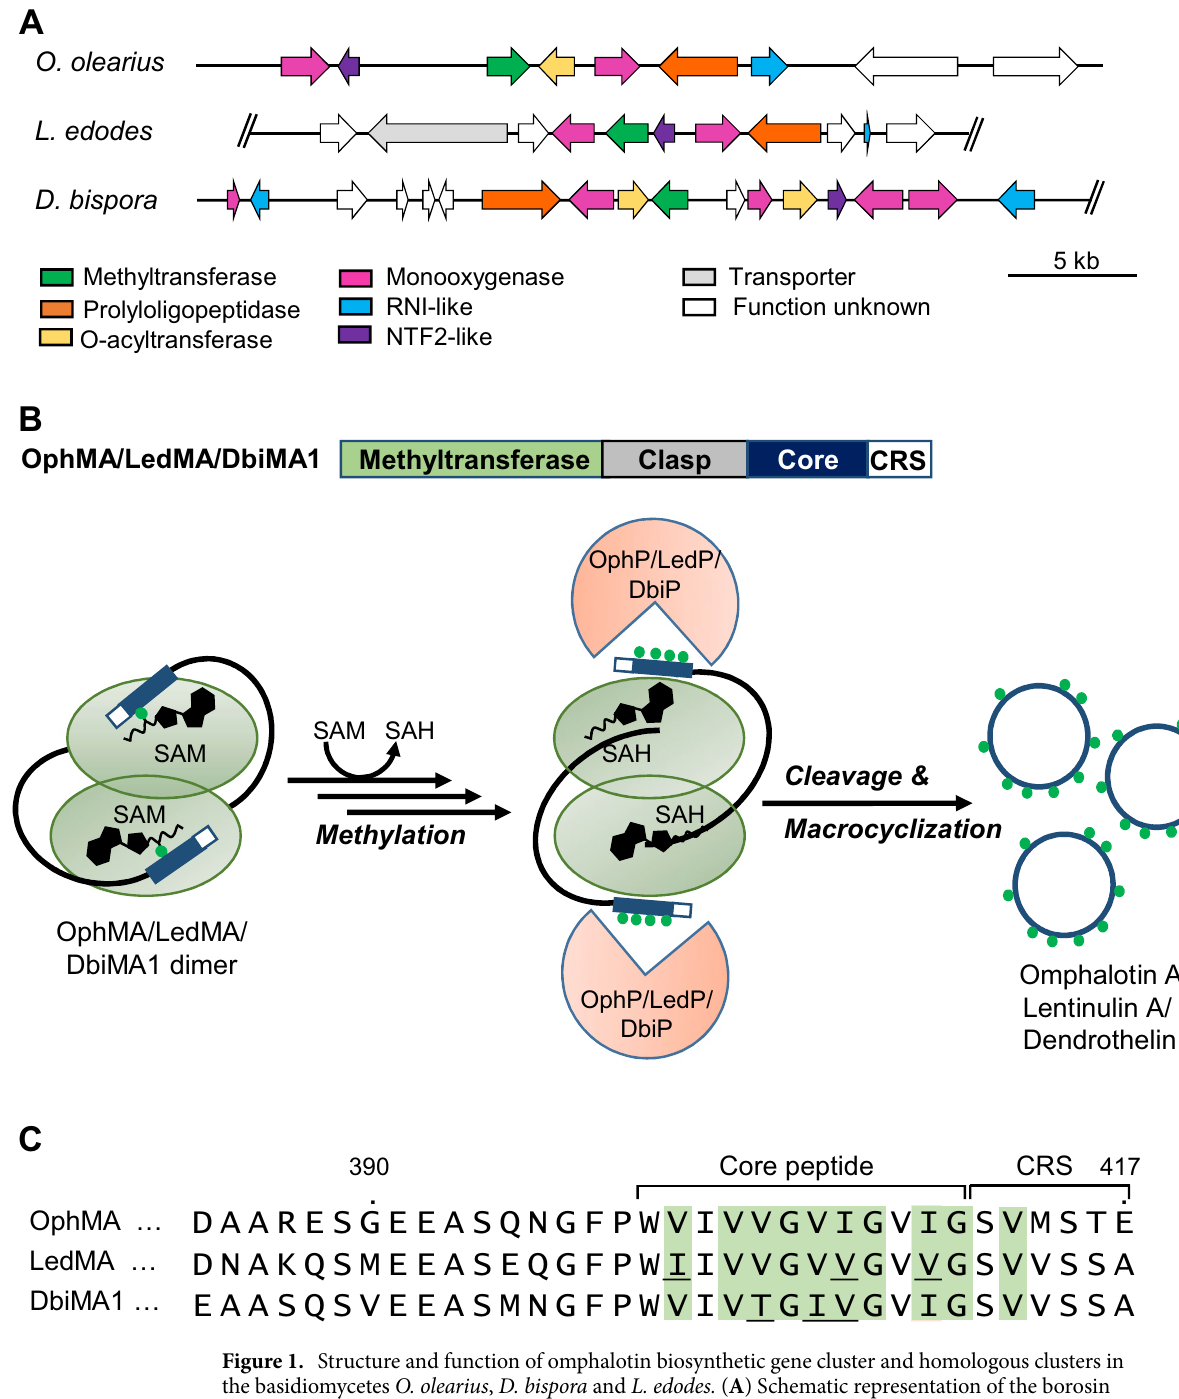
Figure 1. Structure and function of omphalotin biosynthetic gene cluster and homologous clusters in the basidiomycetes O. olearius , D. bispora and L. edodes. ( A ) Schematic representation of the borosin biosynthetic gene clusters in the basidiomycetes O. olearius (VT 653.13, scaffold _ 169), L. edodes (Le(Bin) 0899 ss11, scaffold_10) and D. bispora (CBS 962.96, scaffold_621). All three clusters code for a precursor (methyltransferase) protein, referred to as OphMA, LedMA and DbiMA1 respectively, and a prolyloligopeptidase, referred to as OphP, LedP and DbiP, respectively. The DNA scaffolds and filtered gene models were taken from https:// mycoc osm. jgi. doe. gov/. Double slashes (//) indicate that the sequence of the DNA scaffold continues beyond this position. ( B ) Biosynthesis scheme of omphalotin A and closely related peptides, lentinulin A and dendrothelin A as a combined action of the precursor (methyltransferase) protein and the prolyloligopeptidase. ( C ) Alignment of the C-termini of the precursor (methyltransferase) proteins from O. olearius (OphMA), L. edodes (LedMA) and D. bispora (DbiMA1). Residues differing from the omphalotin core peptide are shown in red. The indicated methylation patterns (green fill) were previously determined by heterologous expression of the respective cDNAs in E. coli 21,23,25 . CRS C-terminal recognition